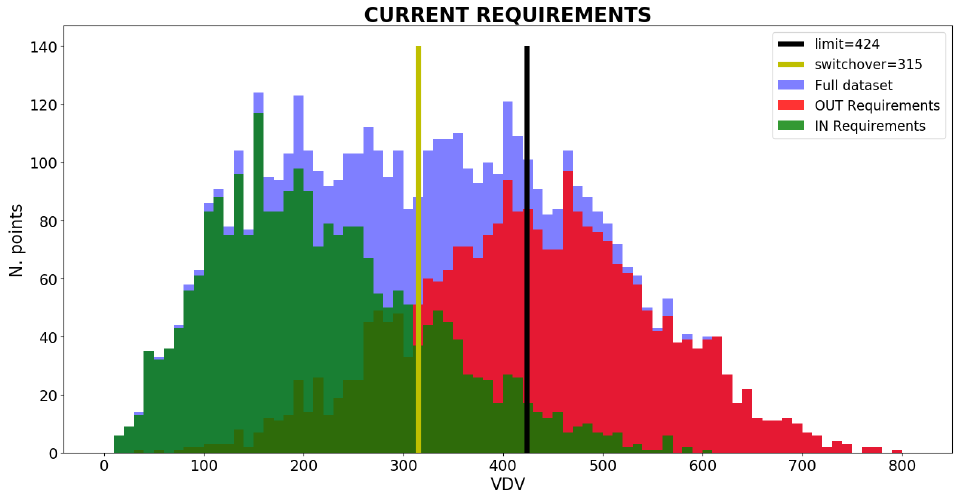
Figure 7. Histogram showing the separation of VDV performance for the engine mount